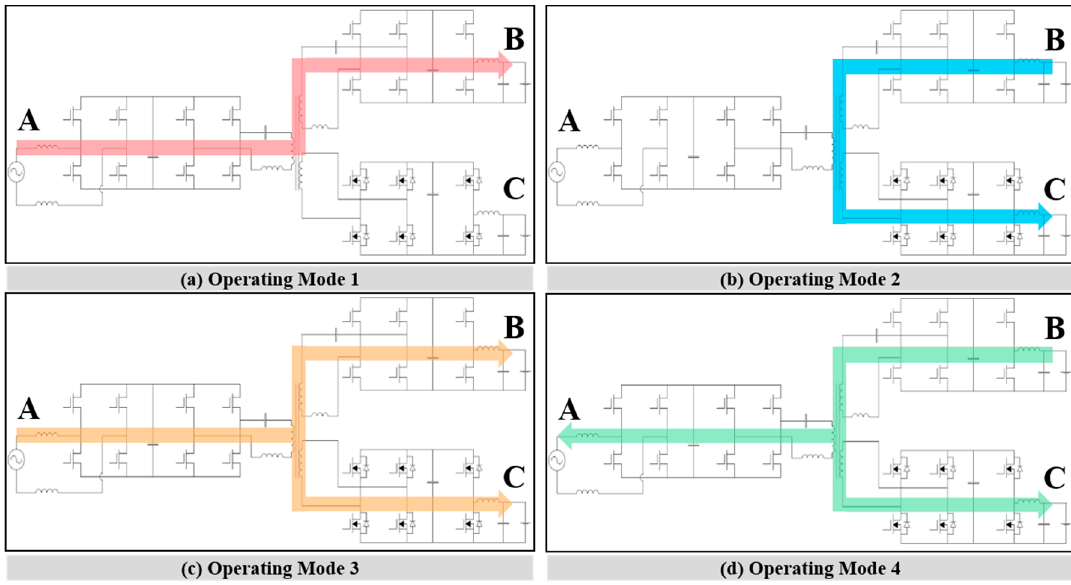
Figure 4. Operating modes in the 7.2 kW integrated bidirectional OBC/LDC module.